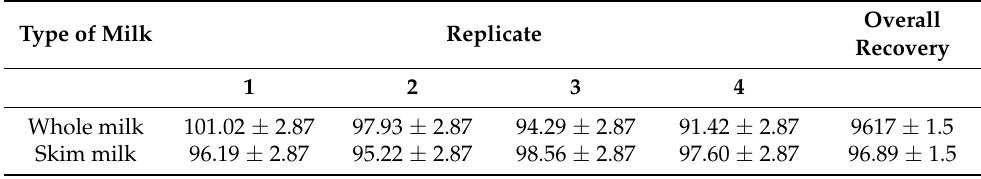
Table 1. The percent recovery 1 of known amount of fucoxanthin spiked into pasteurized goat whole and skim milk.